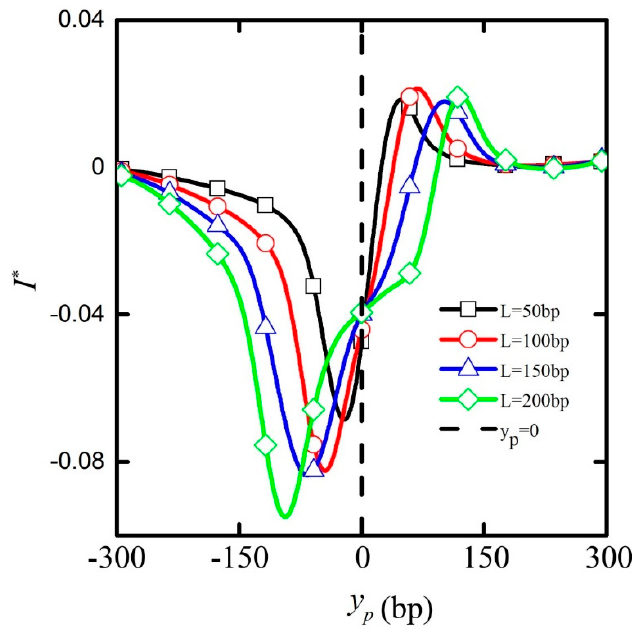
Figure 8. The ion current deviation I * passing through the nanopore depending on the particle position when the applied electric field strength E = 2 MV / m, the particle length is L p = 50 (black line plus frame), L p = 100 (red line plus circle), L p = 150 (blue line plus triangle), and L p = 200 bp (green line plus diamond). The dotted line indicates that the particles reach the center of the nanopore, y p = 0.